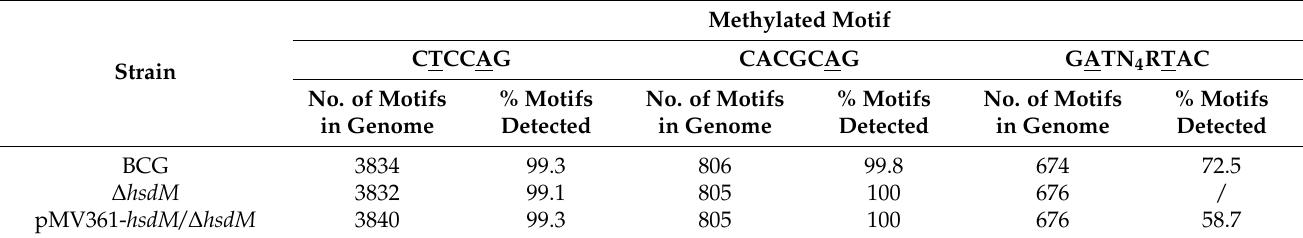
Table 1. N6-methyl-adenine base modifications in sequenced BCG